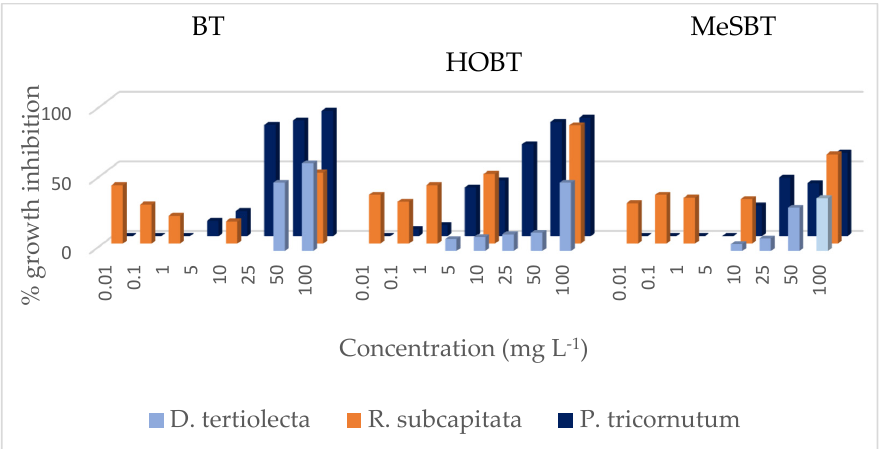
Figure 3. Values of the percentage of growth inhibition produced by the benzenesulfonamides on the three algal species.